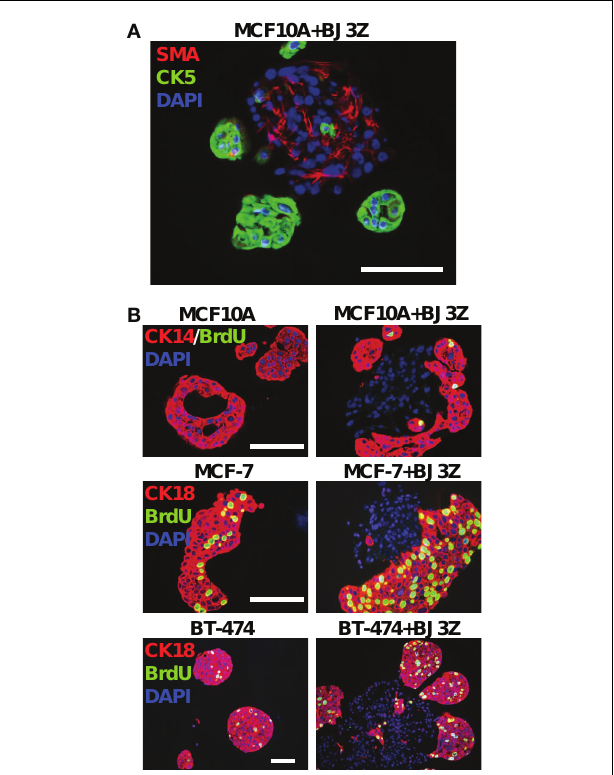
FIGURE 3 |Three-dimensional cell subpopulations and proliferation rates. (A) MCF10A/BJ3Z co-cultures were stained against SMA (red) to tag the mouse stromal cells and anti-human CK5 (green) to tag the MCF10A cells. (B) Proliferation as measured by BrdU incorporation in different cell subpopulations. Human MCF10A, MCF7, or BT-474 cells were grown in 3D mono-culture (left) or in co-culture with BJ3Z mouse stromal cells (right). Anti-CK14 (red) was used for MCF10A cells; anti-CK18 (red) was used for MCF7 and BT-474 cells. All sections were dual stained for BrdU (green) and counterstained with DAPI (blue). Note enhanced proliferation of BJ3Z co-cultured breast cells and lack of stromal cell proliferation.When cells of different species are co-cultured, judicious choice of primary antibody pairs and fluorescent second antibodies is required. Scale: 100 μ m